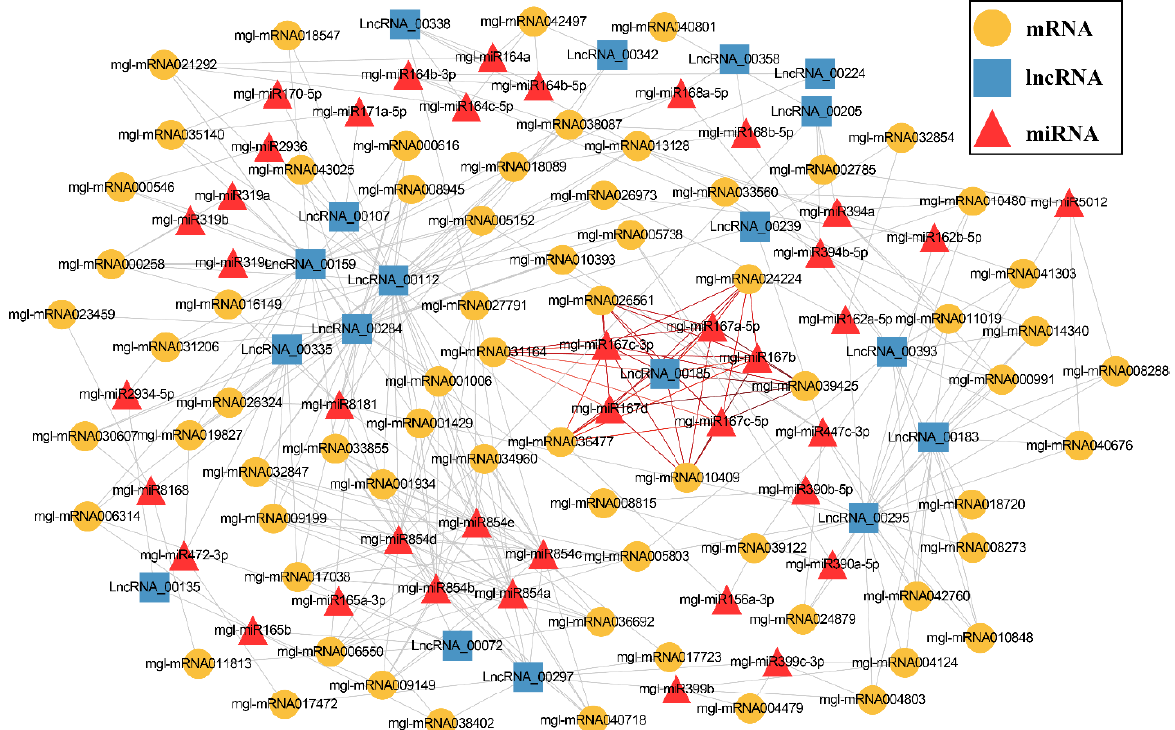
Figure 5. CeRNA networks among lncRNAs, mRNAs, and miRNAs. The red triangles represent miRNAs, the yellow circles represent mRNAs, and the peacock-blue square represent lncRNAs.